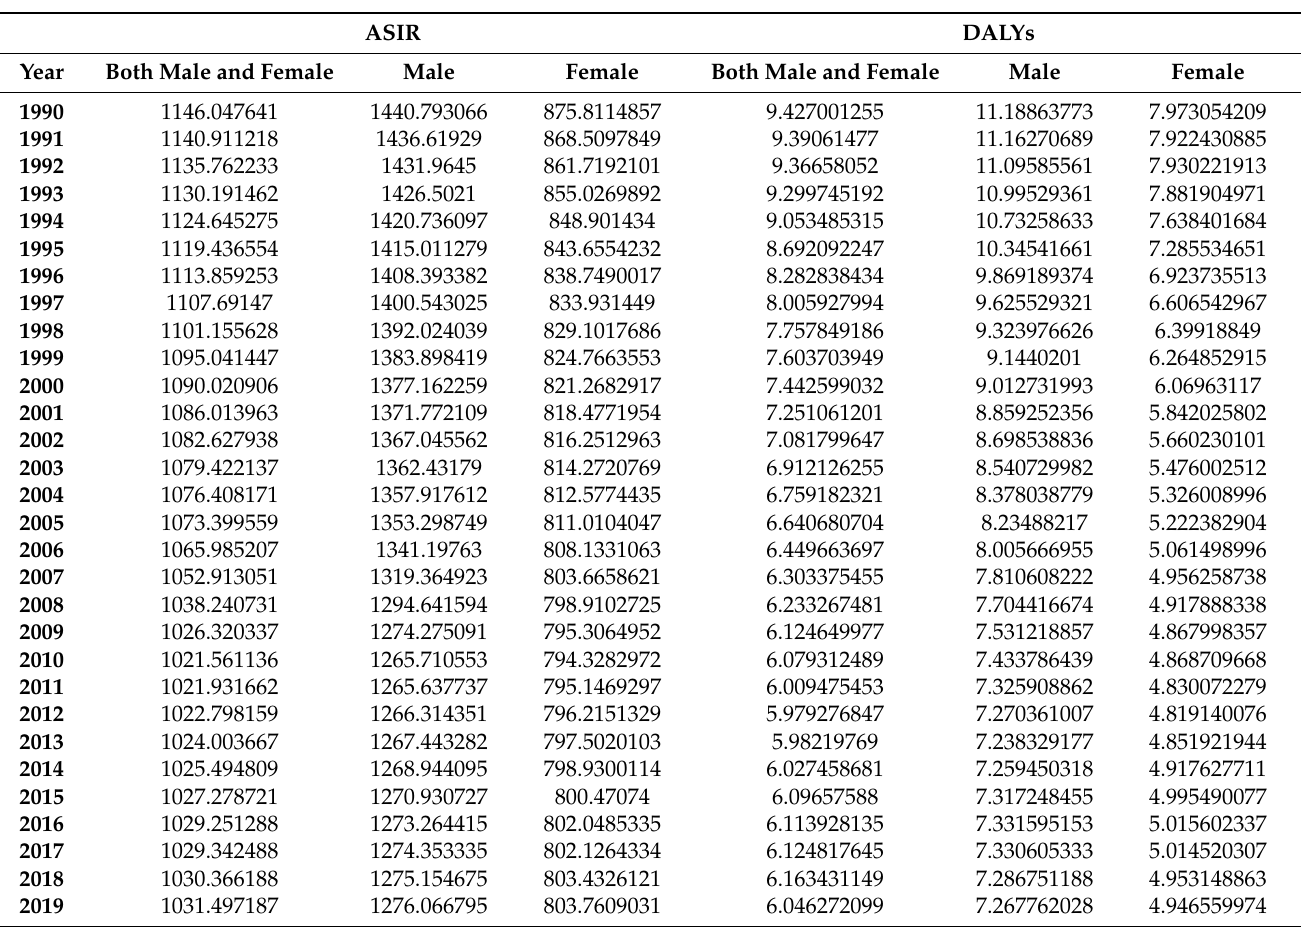
Table 1. The global age standardized incidence rate and disability adjusted life years of urolithiasis from 1990 to 2019 stratified by